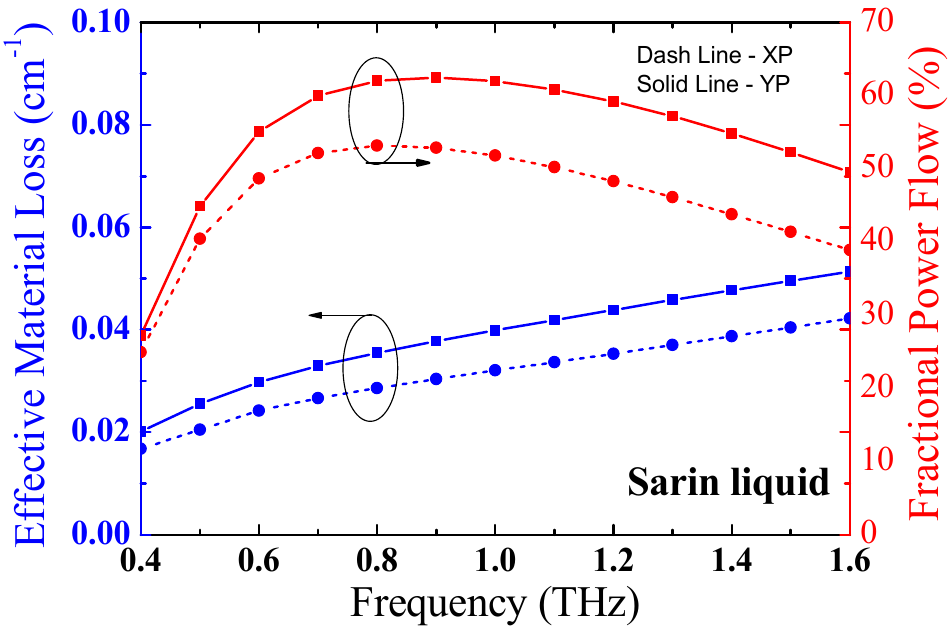
Figure 14. EML and fractional power flow of the proposed sensor when the QE air holes were filled with sarin liquid.